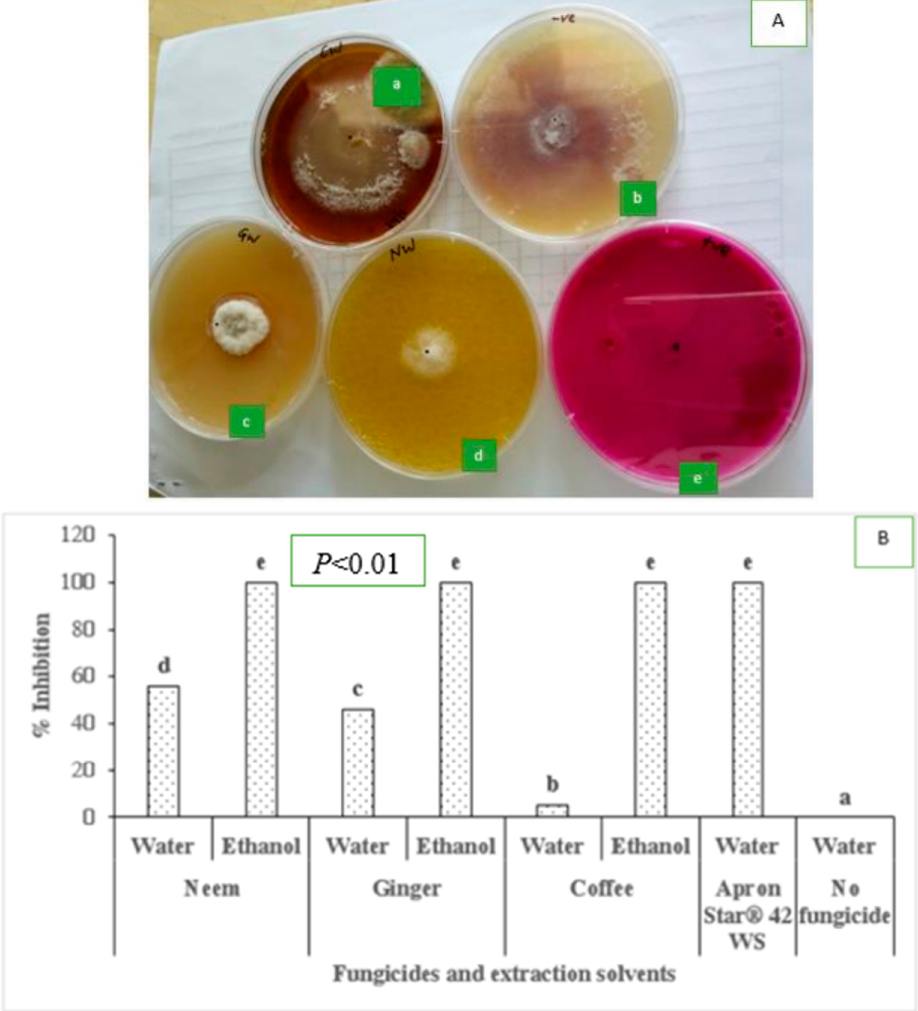
Figure 6. ( A ) Inhibition of mycelial fungal growth due to the application of water-extracted bio- fungicides: (a) coffee; (b) negative control; (c) ginger; (d) neem; (e) positive control (Apron Star ® 42 WS). ( B ) Effects of the interaction between fungicides and extraction solvents on inhibition of mycelial growth of F. verticillioides. Means with the same letters along the same bars are not significantly different ( p < 0.05).